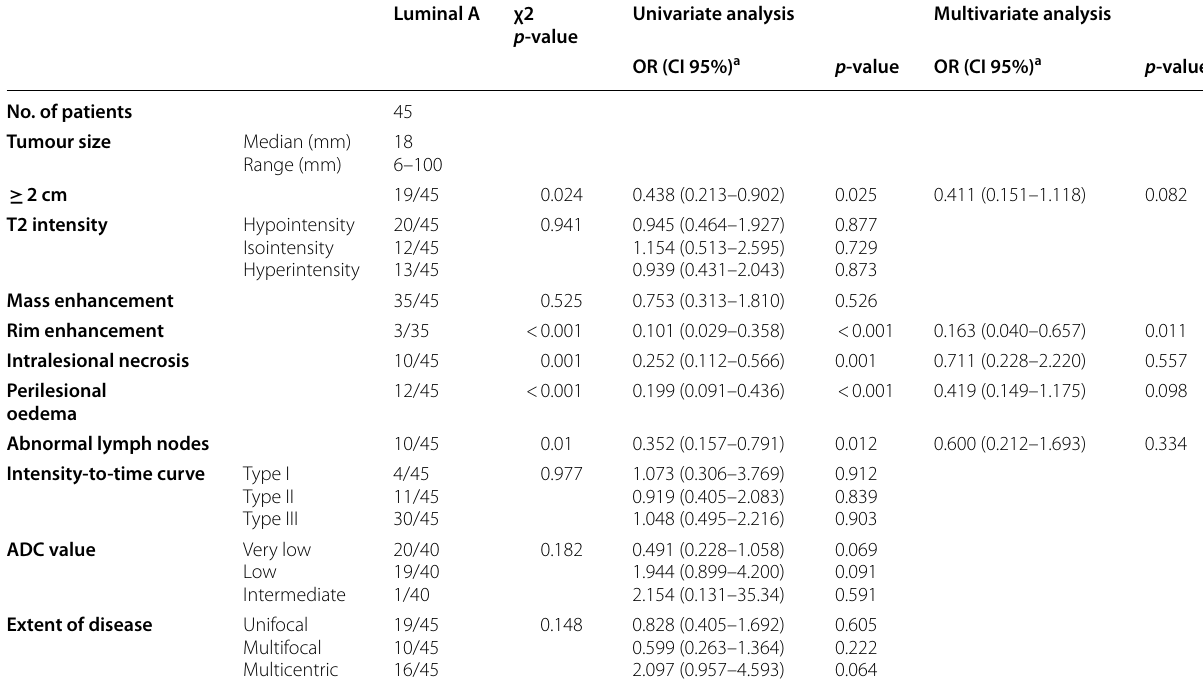
a OR Odds ratio, CI Confidence interval, ADC Apparent diffusion